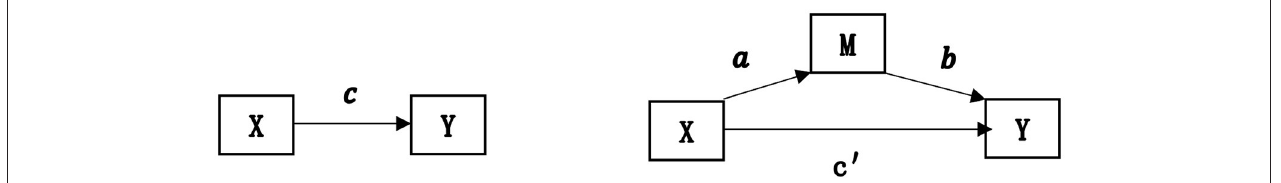
FIGURE 2 | Influence path of the mediating variables. It illustrates that the independent variable X affects the dependent variable Y through the mediating variable M. X is the reimbursement ratio of the New Rural Cooperative Medical Scheme (RRN). Y represents self-rated health. M represents a “local medical service